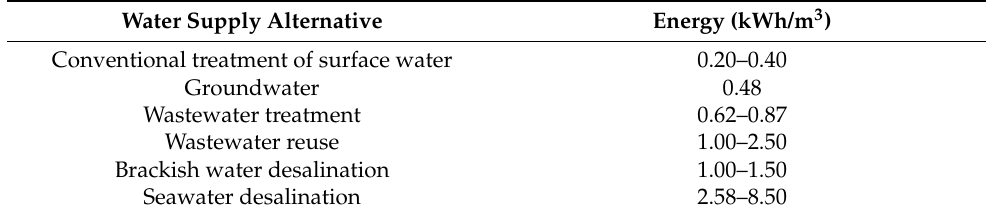
Table 1. Required energy use of distinct water sources for 1 m 3 of drinking water [30,31].